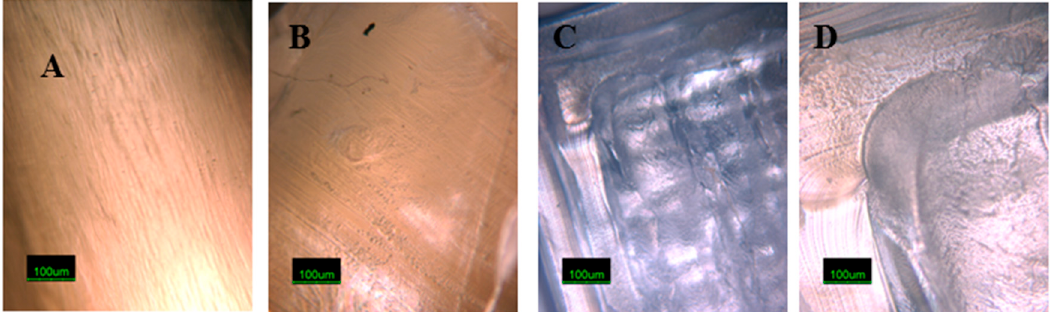
Figure 1. Optical images of the source and printed polylactic acid (PLA). (A) Lengthwise section of PLA spool material (B) Cross ‐ section of spool material (C & D) 3D printed PLA